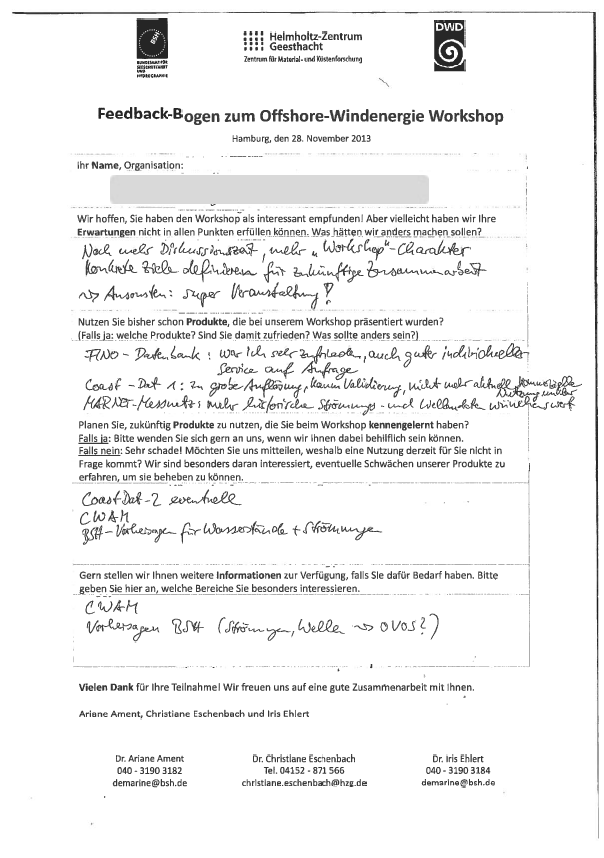
Figure 4. Feedback sheet as an